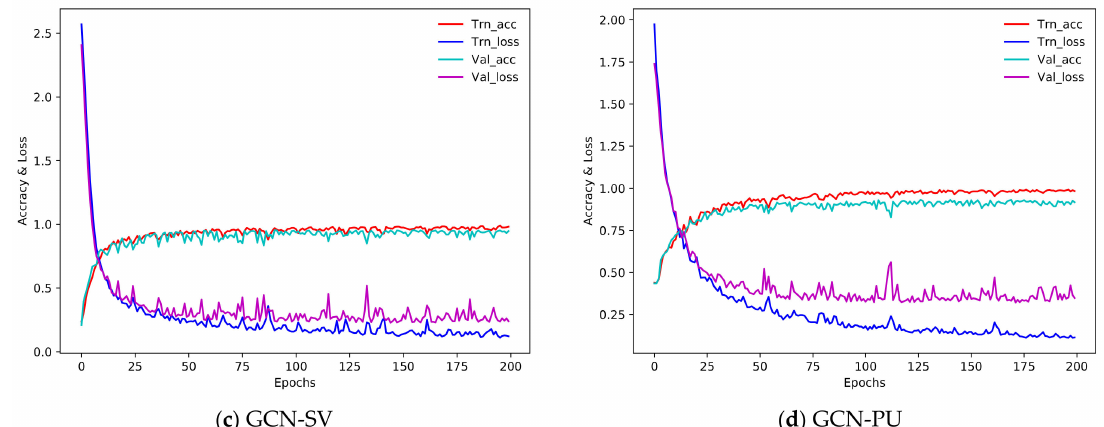
Figure 5. The accuracy & loss curves of the CNN and GCN models in the 1st run for the SV and PU datasets, i.e., ( a ) CNN-SV, ( b ) CNN-PU, ( c ) GCN-SV, ( d ) GCN-PU, corresponding to the experiment with five random